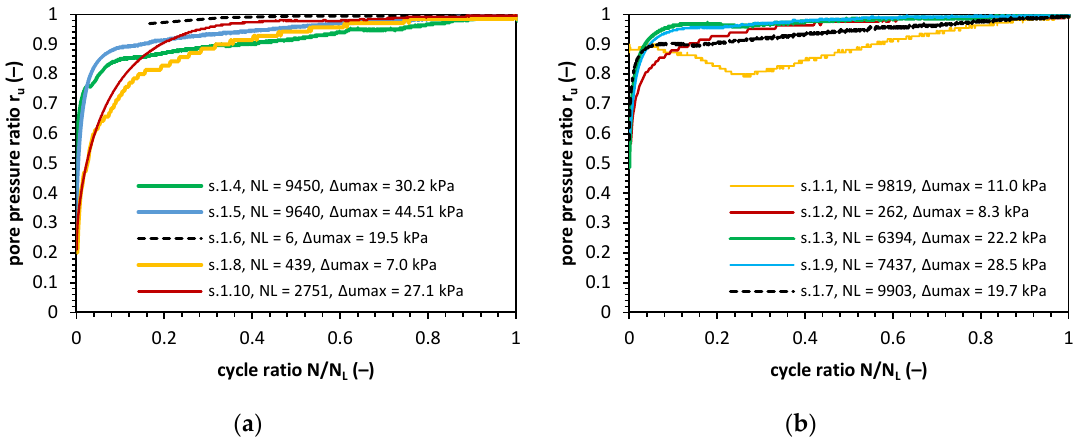
Figure 7. Pore pressure ratio for the test results in confining pressure equal to 18, 90 and 135 kPa ( a ), and for the samples consolidated with confining pressure equal to 45 kPa ( b ).